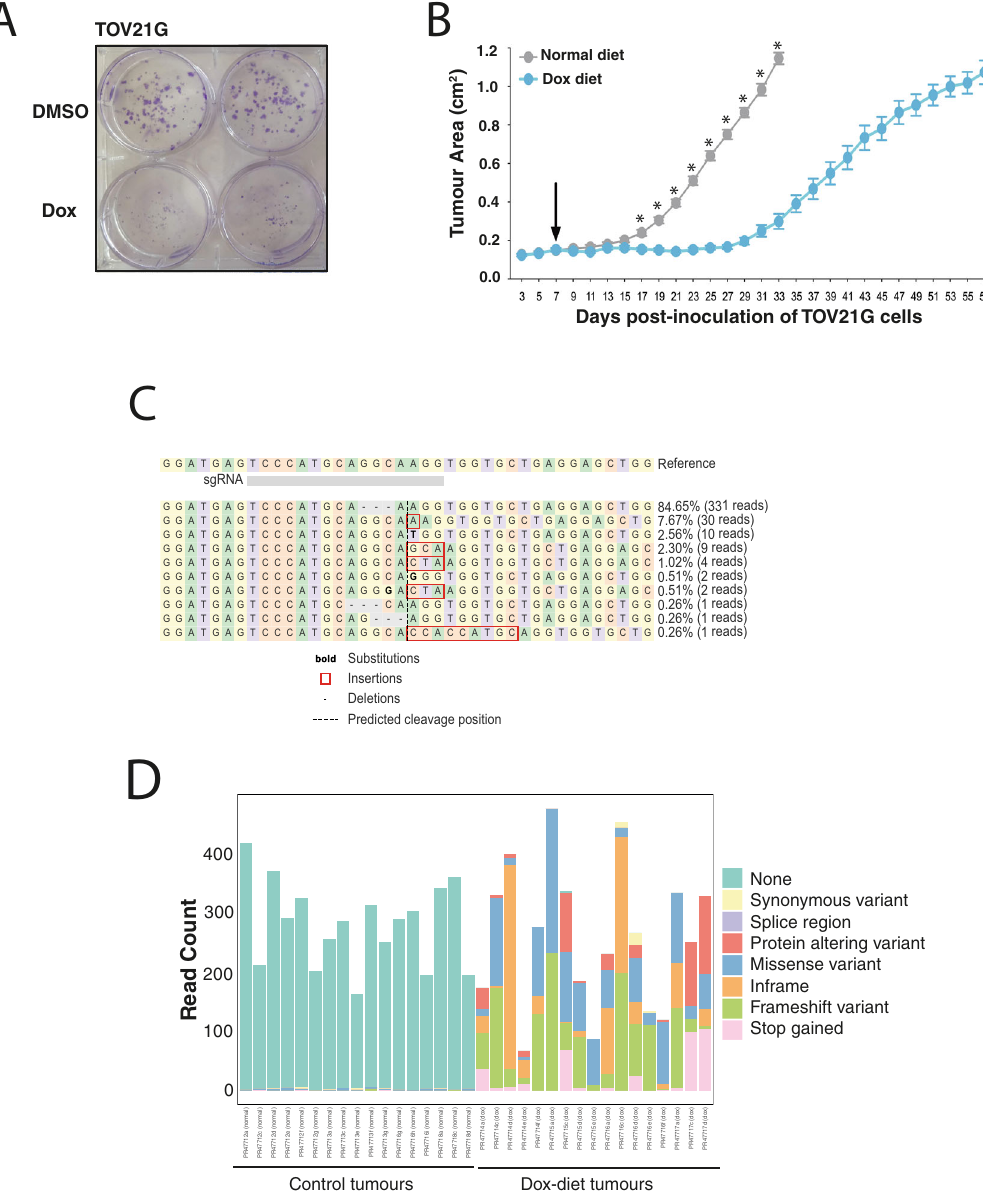
Fig. 4 Effect of FAM50A loss on TOV21G cell growth in vivo and mechanisms of resistance. A Conditional disruption of FAM50A in FAM50B non- expressing TOV21G cells engineered (see Methods) to contain a dox-inducible FAM50A gRNA. B In vivo consequence of disrupting FAM50A in TOV21G cells on tumour growth. Data points represent the mean and SEM (see Methods). Dox diet was administered at the day 7 timepoint (arrow). Signi fi cance was de fi ned using a two-tailed Mann – Whitney test by comparing the area under the curve for tumour growth in the Dox-fed and control groups. * p < 0.0001. These data are representative of two independent experiments. C An example of the FAM50A gRNA cut site showing the pro fi le of editing events in a doxycycline (Dox)-treated tumour after regrowth. D Editing outcomes at the FAM50A gRNA cut site in tumours collected from untreated (left) and Dox-fed mice (right). The editing events were annotated using the Variant Effect Predictor (Ensembl). The Y axis is read